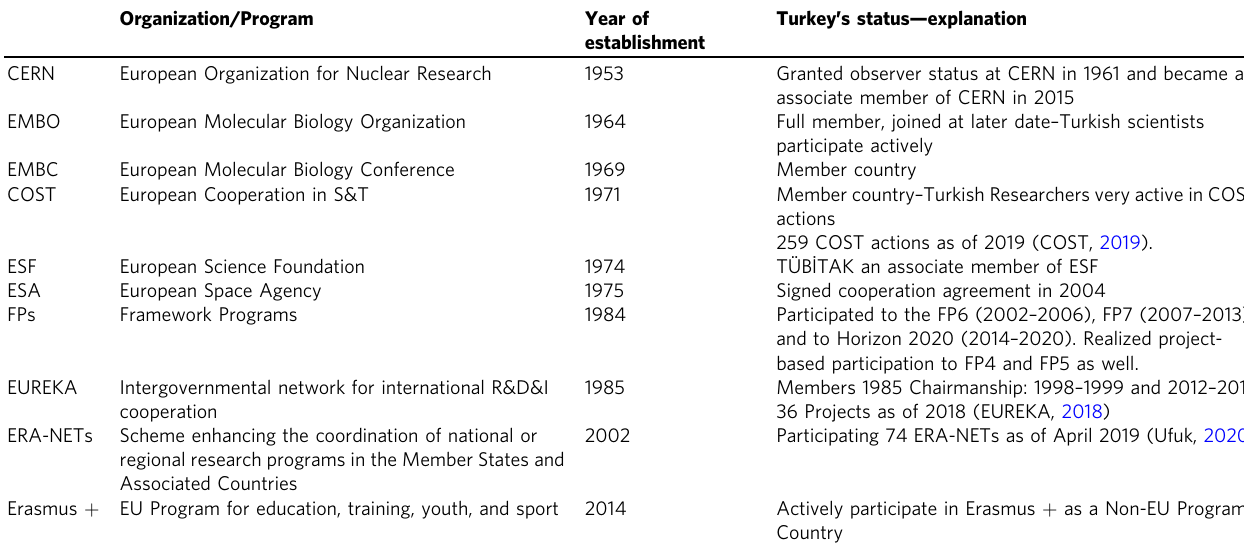
Table 2 Turkey ’ s engagement in major European organizations and programs on STI and